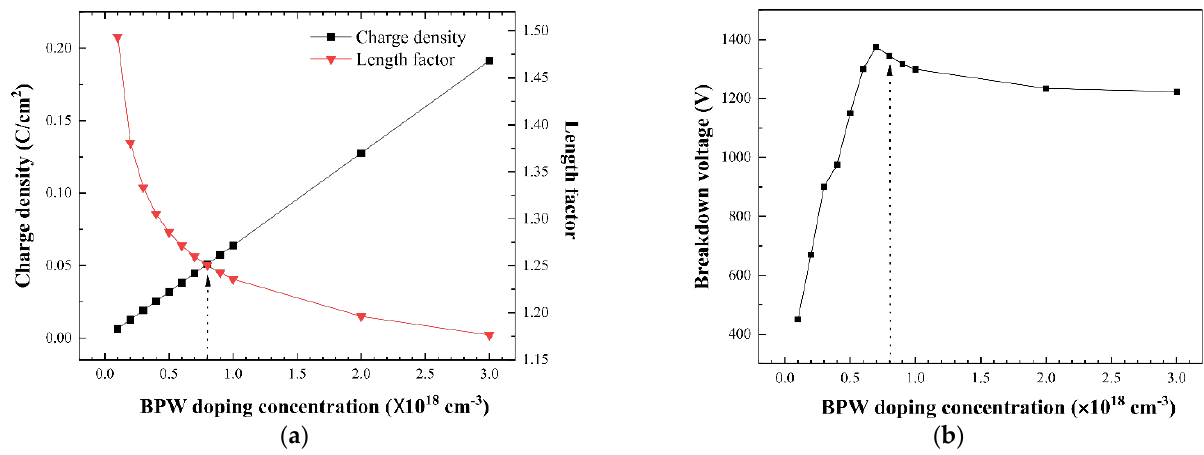
Figure 3. ( a ) Charge density, length factor, and ( b ) the breakdown voltage of the TMOSFET according to BPW doping concentrations.